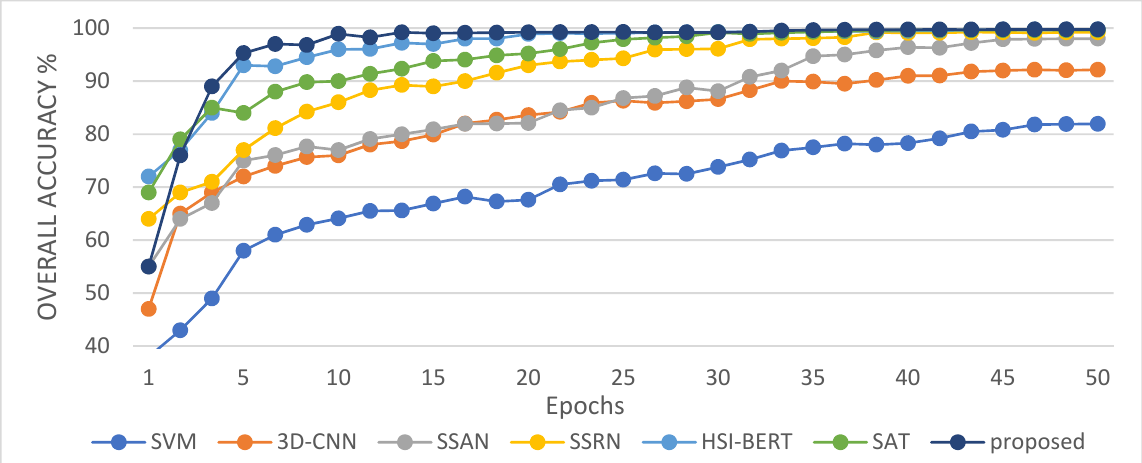
Figure 13. Overall accuracy curve of different models in UP dataset.